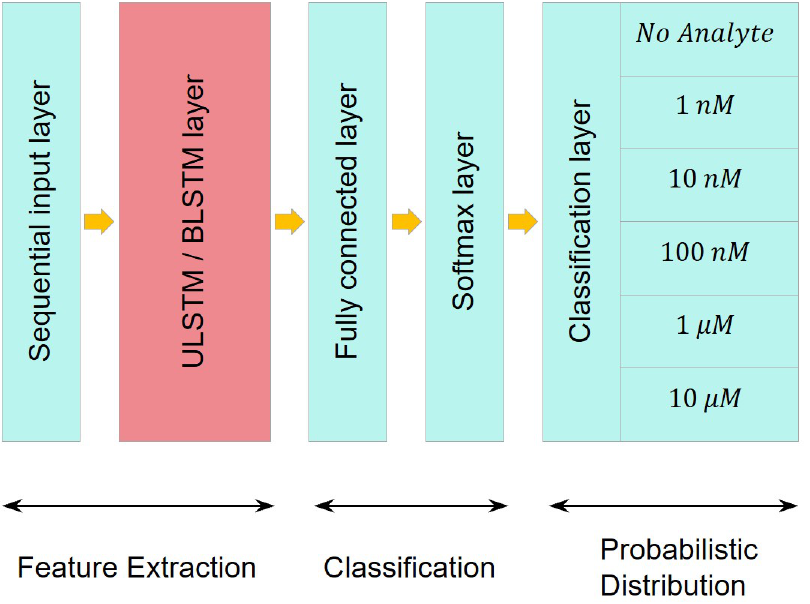
Figure 5. A schematic of the network architecture. Note that the only difference between the two networks was in their LSTM layer, which used either a unidirectional or a bidirectional LSTM layer. Table 4 describes and compares the layers and the properties of the unidirectional and bidirectional LSTM networks depicted in Figure 5. Recall that the size of the input layer entering the networks was equal to the length of the segments and was considered as one se- quence, and the output size of the networks ( m ) was identical to the number of classes in the data. It should be mentioned that all of the input weights, the recurrent weight, and the bias matrices were concatenated together to form the input weights ( W x = [ W ix ; W fx ; W cx ; W ox ] ),